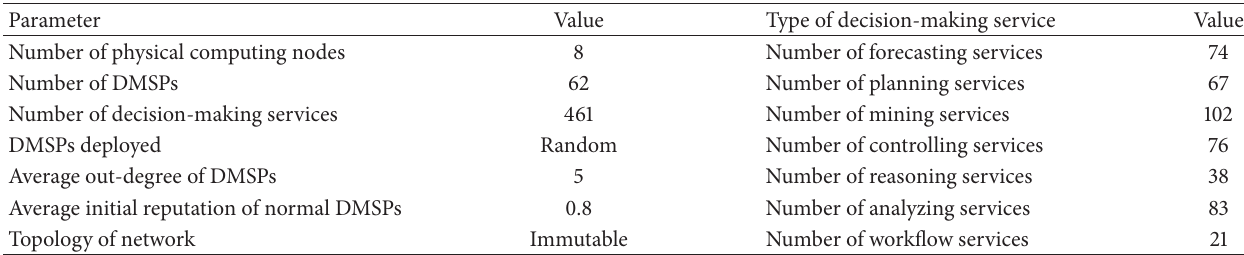
Table 1: The detailed information about our